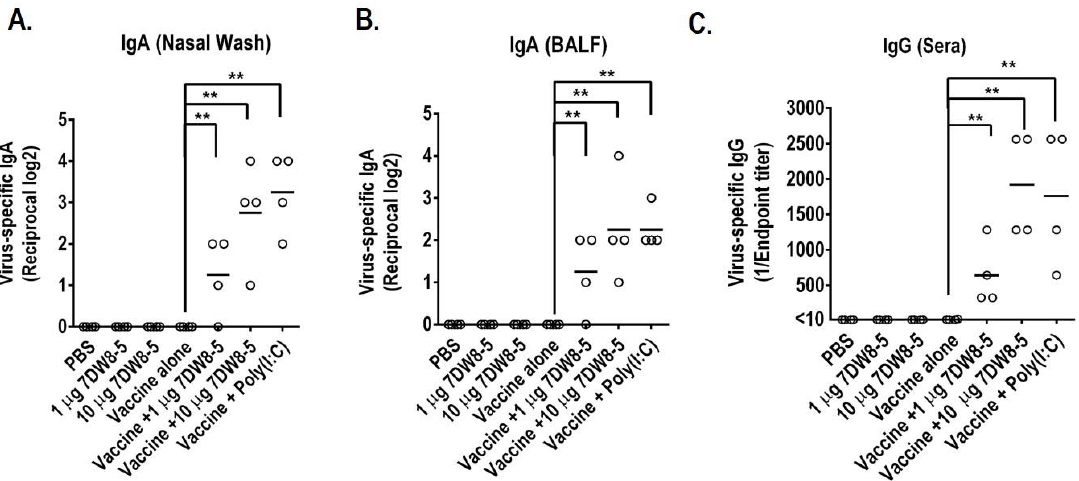
Figure 1. Virus-specific secretory IgA (S-IgA) titers in the respiratory tract and IgG in sera induced by intranasal co-administration of 7DW8-5 with the split inactivated influenza vaccine. Six-week-old BALB/c mice were intranasally immunized with the indicated immunogens (20 µ L total, 10 µ L/nostril) twice with a two-week interval between immunizations. Four mice were used per group. Nasal wash (NW) and bronchoalveolar lavage fluid (BALF) samples were collected two weeks after the last immunization to measure virus-specific secretory IgA and IgG antibody titers. The virus-specific IgA and IgG titers were determined by use of an ELISA with inactivated CA07 virus as the coating antigen. The OD was measured at a wavelength of 405 nm. The antibody titer was defined as the reciprocal of the highest dilution that produced an OD405 >0.1 after correcting based on the negative serum control. The values are the means ± SD of the four individual antibody titers per group. ( A ) Virus-specific IgA antibody titers in the NWs induced by intranasal co-administration of 7DW8-5 with the split inactivated influenza vaccine. ( B ) Virus-specific secretory IgA antibody titers in the BALFs. ( C ) Virus-specific IgG antibody titers in sera. ** p <